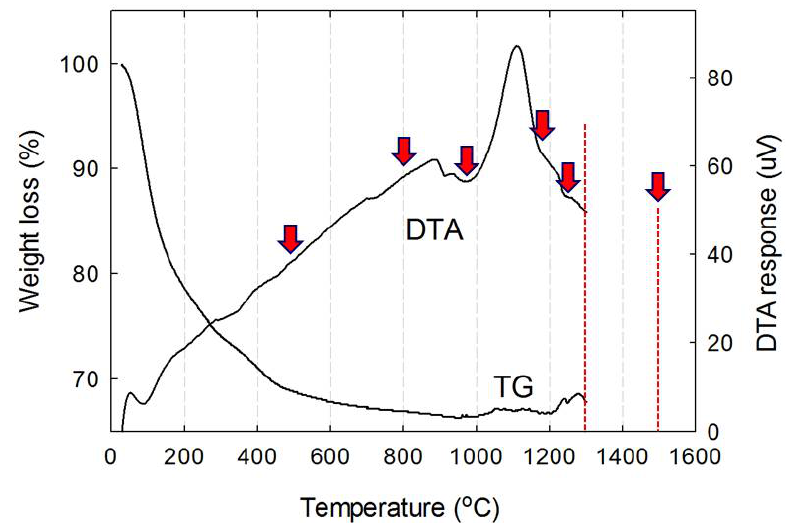
Figure 2. Thermogravimetry (TG) and differential thermal analysis (DTA) curves of silica-alumina nanoparticles, a mullite-silica precursor.